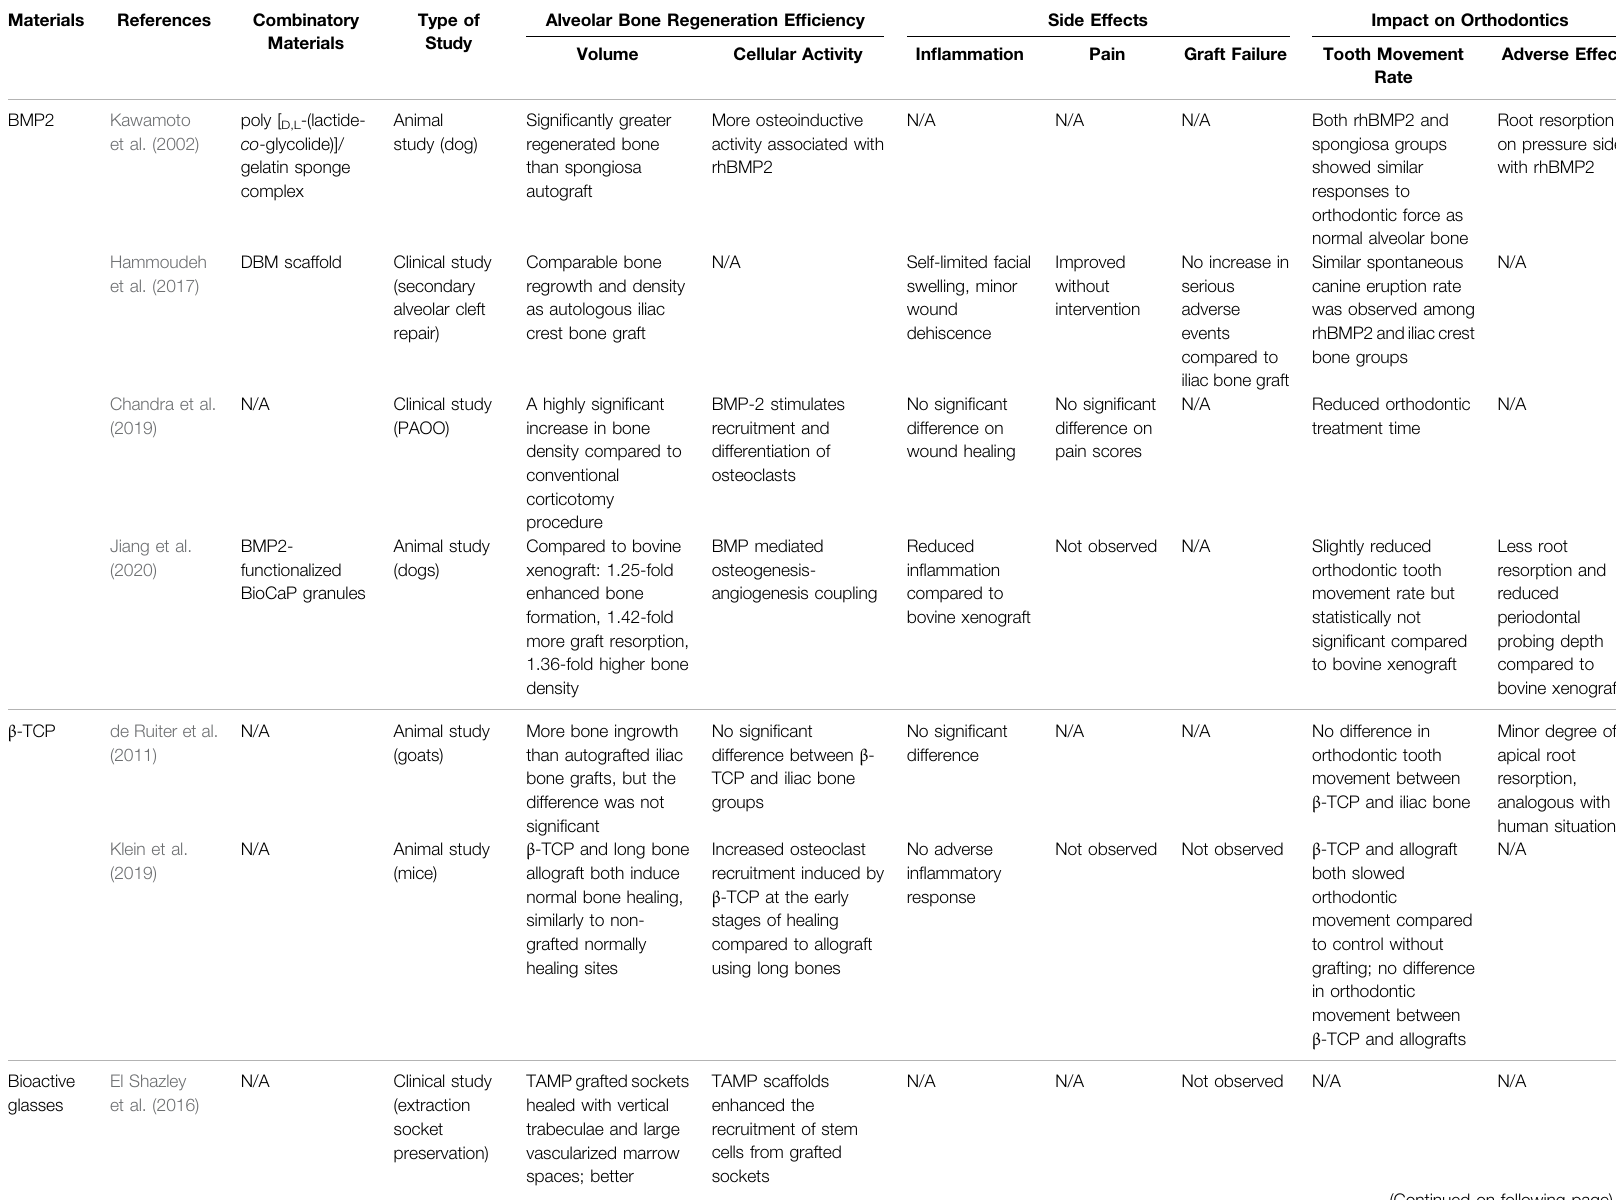
TABLE 1 | The alveolar bone regeneration ef fi ciency and the orthodontic impactions of the alveolar bone grafting materials.